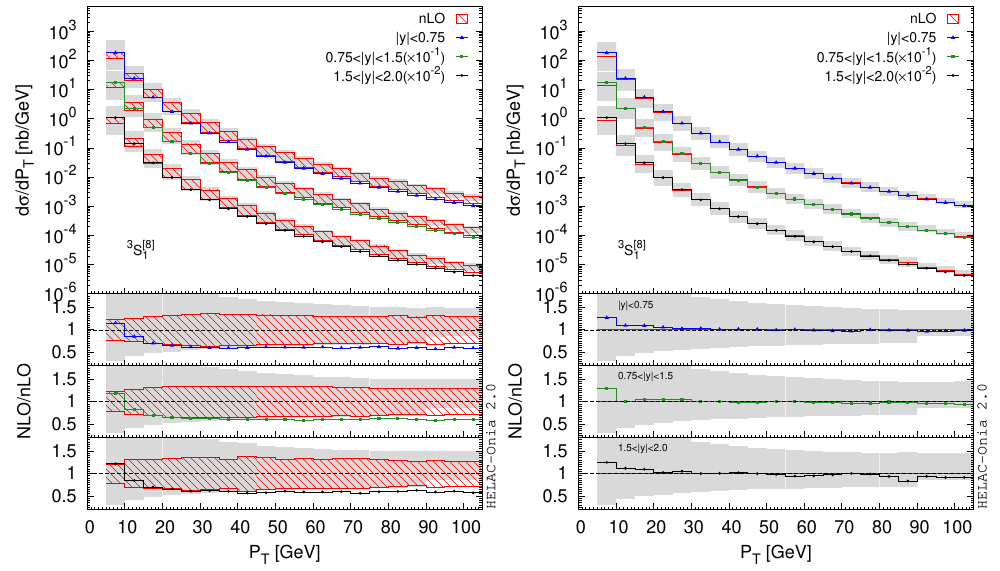
Figure 6 . Comparisons of spin-summed differential cross sections for the Fock state 3 S [8] nLO (left), tunned nLO with z